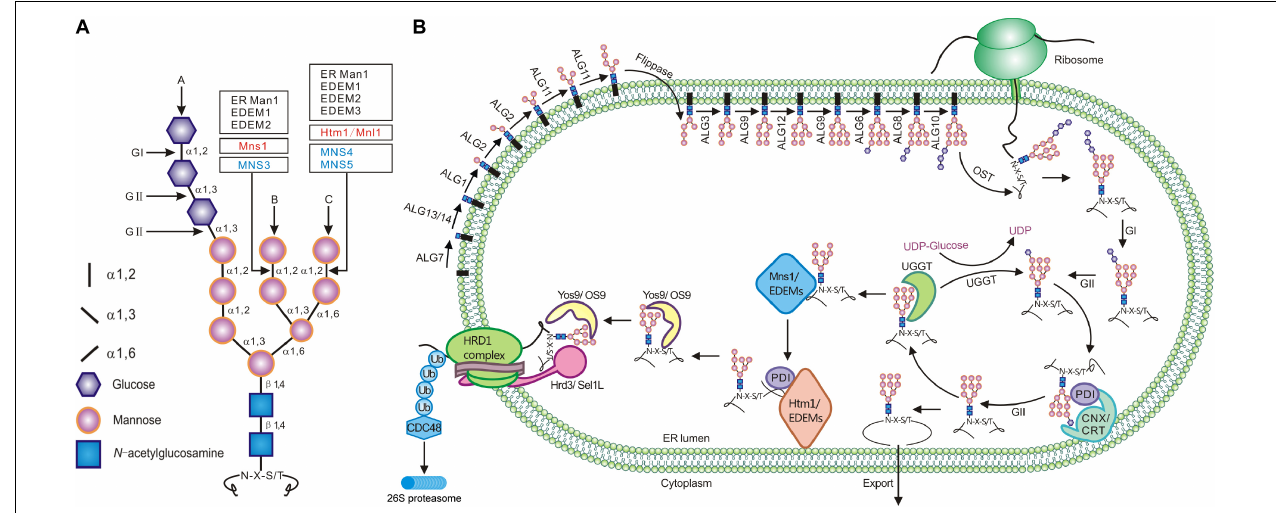
FIGURE 1 | The synthesis of N -glycan and its role in ERQC. (A) The structure of the three-branched Glc 3 Man 9 GlcNAc 2 . The inlet lists signs/shapes for different sugars and glycosidic linkages. Vertical arrows mark three different branches while the horizontal arrows indicate the cleavage sites of glucosidases and mannosidases. (B) The assembly of the N -glycan precursor starts at the cytosolic side of the ER membrane with addition of two GlcNAc residues to the membrane-anchored Dol-P linker followed by sequential attachment of the β 1,4Man residue (catalyzed by ALG1), the α 1,3Man/ α 1,6Man residues (by ALG2), and the two α 1,2Man residues (by ALG11). The resulting Man 5 GlcNAc 2 -PP-Dol is flipped into the ER lumen where four additional Man residues are sequentially added from Dol-P-Man donor (catalyzed by ALG3, ALG9, ALG12, and ALG9) to generate Man 9 GlcNAc 2 -PP-Dol. ALG6, ALG8, and ALG10 catalyze the sequential addition of three Glc residues to form Glc 3 Man 9 GlcNAc 2 that is en bloc transferred by OST onto certain Asn residues of nascent polypeptides. Immediately after the transfer, GI and GII rapidly remove the terminal and middle Glc residues to generate GlcMan 9 GlcNAc 2 . This N -glycan is recognized and bound by CNX/CRT that recruit additional chaperones and folding catalysts to assist the folding of those monoglucosylated glycoproteins. The removal of the last Glc residue by GII releases the glycoproteins from CNX/CRT. A correctly folded glycoprotein is demannosylated on the B-branch by Mns1/ERManI while trafficking to the Golgi apparatus whereas a misfolded/incompletely folded glycoprotein is recognized/bound by UGGT that adds back a Glc residue to regenerate GlcMan 9 GlcNAc 2 , forcing its reassociation with CNX/CRT for refolding. If a misfolded glycoprotein stays in the ER too long for engaging multiple futile refolding attempts, its N -glycans are slowly demannosylated by Mns1/ERManI and members of the Htm1/EDEM family (likely forming a disulfide bridged complex with members of the PDI family), generating N -glycans with an exposed α 1,6Man residue. The ERAD lectin (OS-9/Yos9/EBS6) recognizes/binds α 1,6Man-exposed N -glycans and works together with Hrd3/Sel1L/EBS5, which binds surface-exposed hydrophobic residues, to bring an irreparable misfolded glycoprotein onto the ER membrane-anchored ERAD complex containing a ubiquitin ligase (such as Hrd1) and its accessary factors. This complex not only ubiquitinates but also retrotranslocates a committed ERAD client that is subsequently escorted into the cytosolic proteasome for its complete